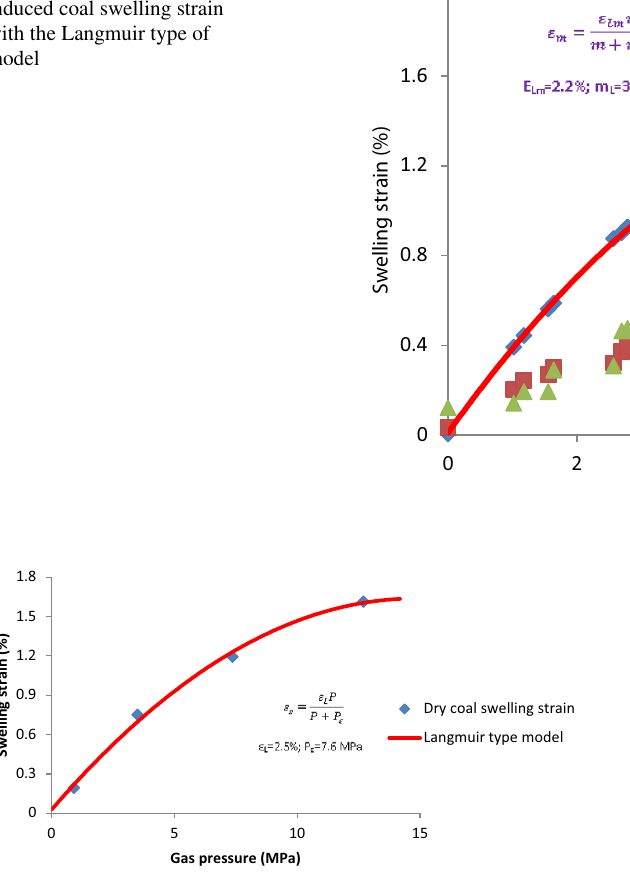
Fig. 6 Moisture sorption- induced coal swelling strain with the Langmuir type of model